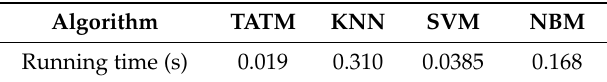
Table 5. Running time of different algorithms